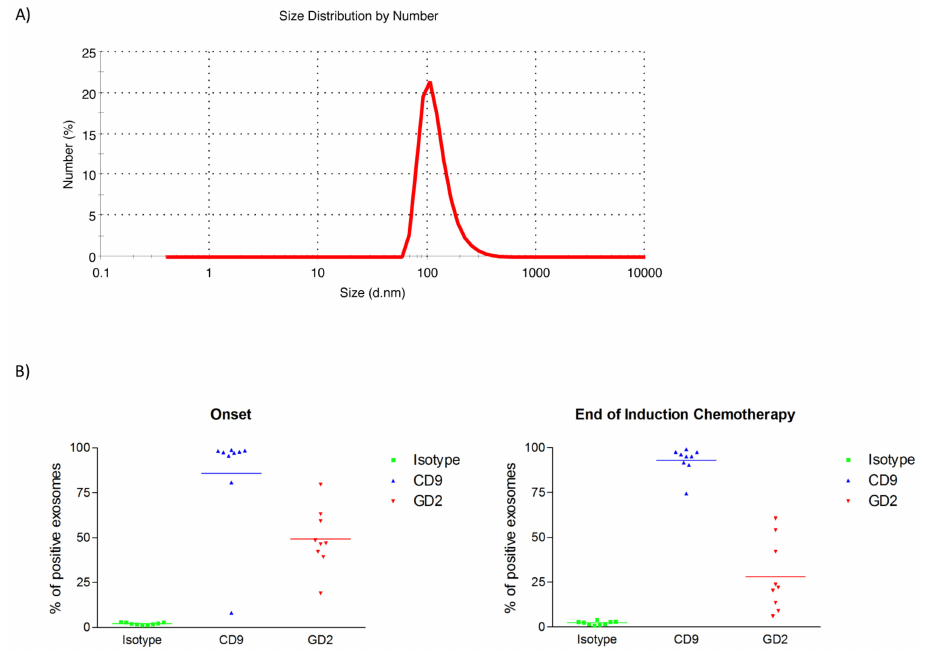
Figure 1. Characterization of exosomes isolated from plasma of high-risk neuroblastoma (HR-NB) patients and of small RNA content. ( A ) Dynamic light scattering analysis shows the size distribution of isolated microvesicles from a representative NB patient. The diameter (nanometers) is reported on X-axis, while the number of microvesicles is on the Y-axis. ( B ) Flow cytometry results show the percentage of CD9 + vesicles and GD2 + exosomes in a subset of patients before (n = 9) and after (n = 9) induction chemotherapy. The di ff erence in GD2 + exosomes observed after treatment is significant (Wilcoxon signed rank test, p value <